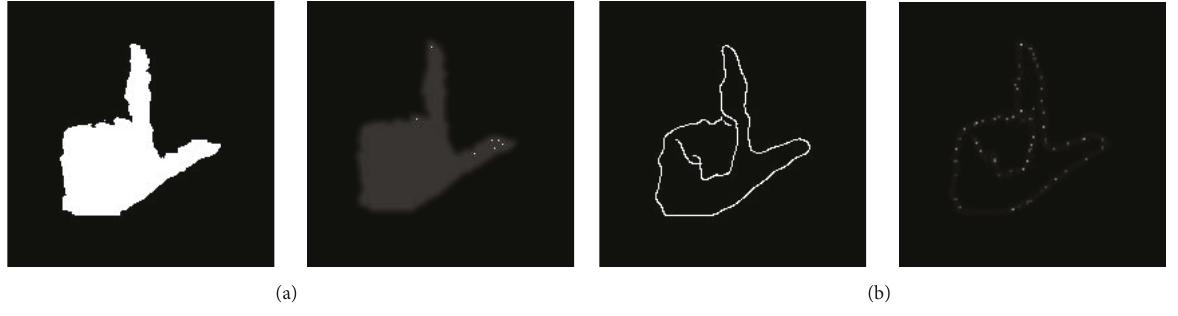
Figure 9: SIFT keypoints on binary image (a) and edge image (b).